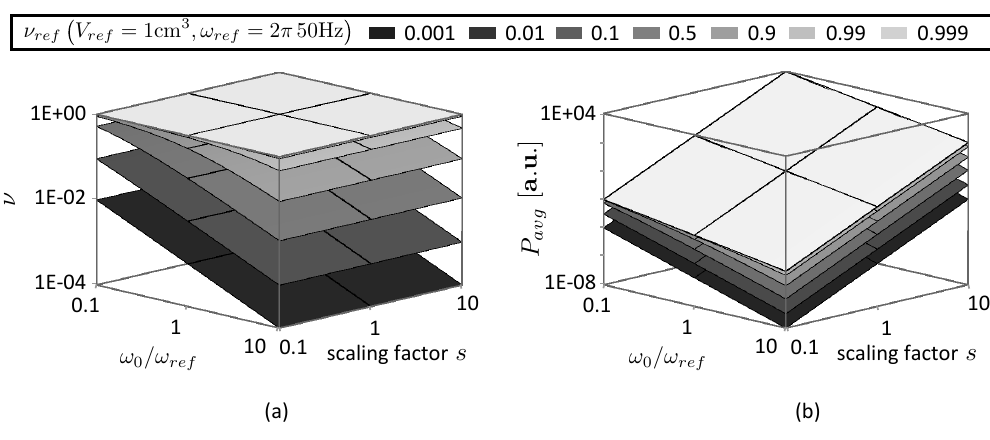
( a ) conversion effectiveness ν with respect to scaling factor s according to Equation (12) and ( b ) average power P at the eigenfrequency according to Equation (13) avg for different ν ref